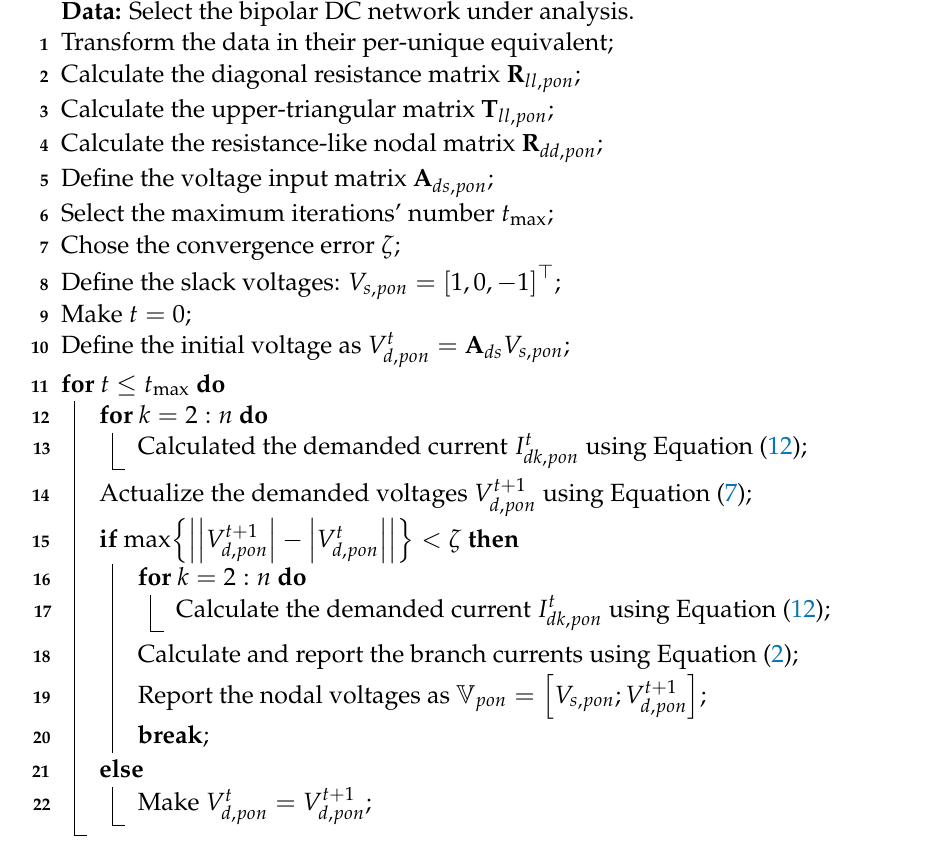
Algorithm 1: Power flow solution using the triangular-based formulation for multiple constant power